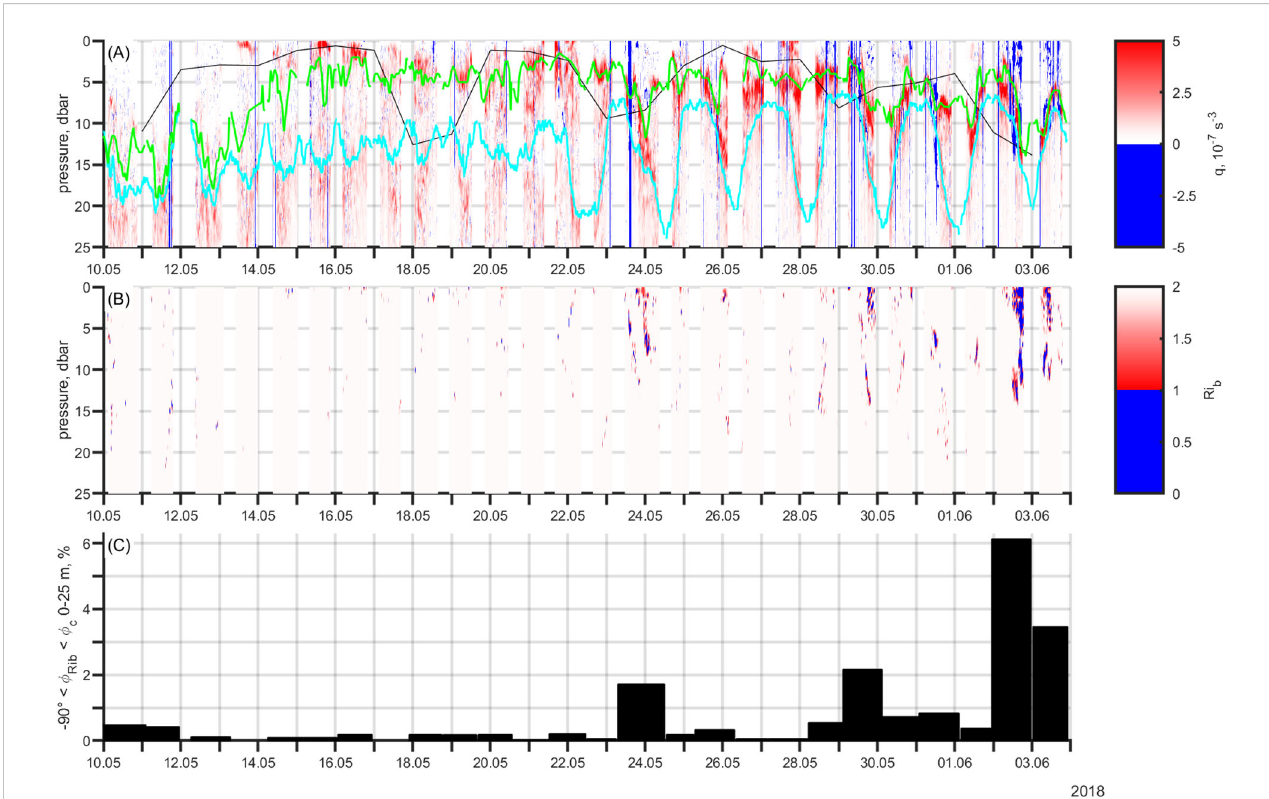
FIGURE 7 (A) Potential vorticity, q , and (B) balanced Richardson number, Ri b , during the study period in May – June 2018. The Obukhov length (black), the depth of the upper mixed layer (green), and the boundary of the CIL (cyan) are shown with potential vorticity. We have emphasized respectively q< 0 and 0< Ri b < 1 in solid blue. (C) The percentage of balanced Richardson angle in the range of – 90° to determined critical angle of -45° in the upper 25 m per sampled